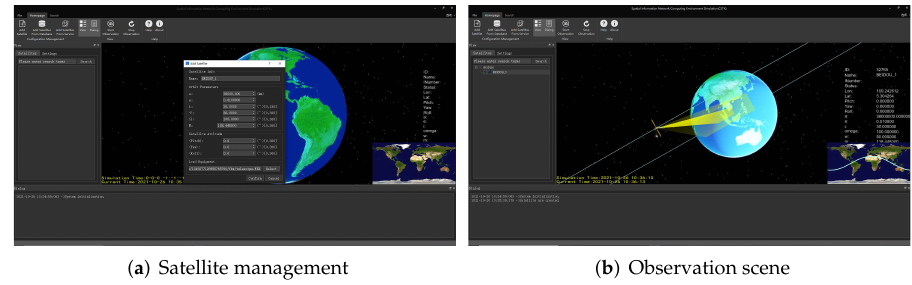
Figure 5. Spatial information network computing environment simulation platform.